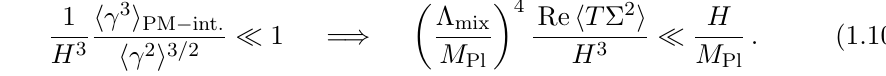
Figure 5 . Corrections to the graviton power spectrum due to insertions of T Σ 2 (right). The first diagram is represents the familiar result h i and